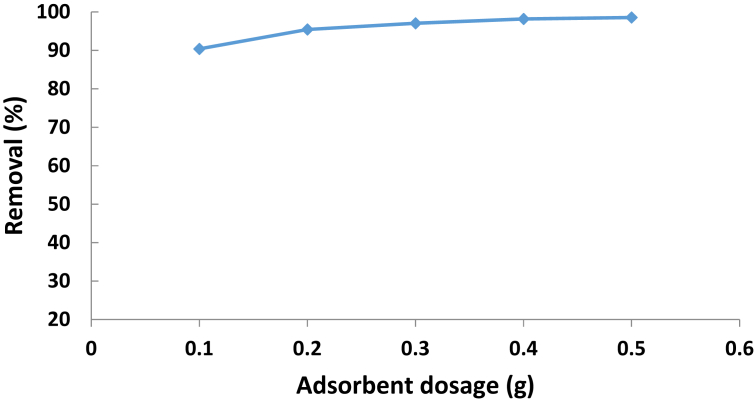
Adsorbent dosage effect on Pb2+ adsorption for HCl activated Aloji clay (Time = 60 min, Temperature = 30 °C, V = 100 mL and initial Concentration = 100 mg/L, pH 7).